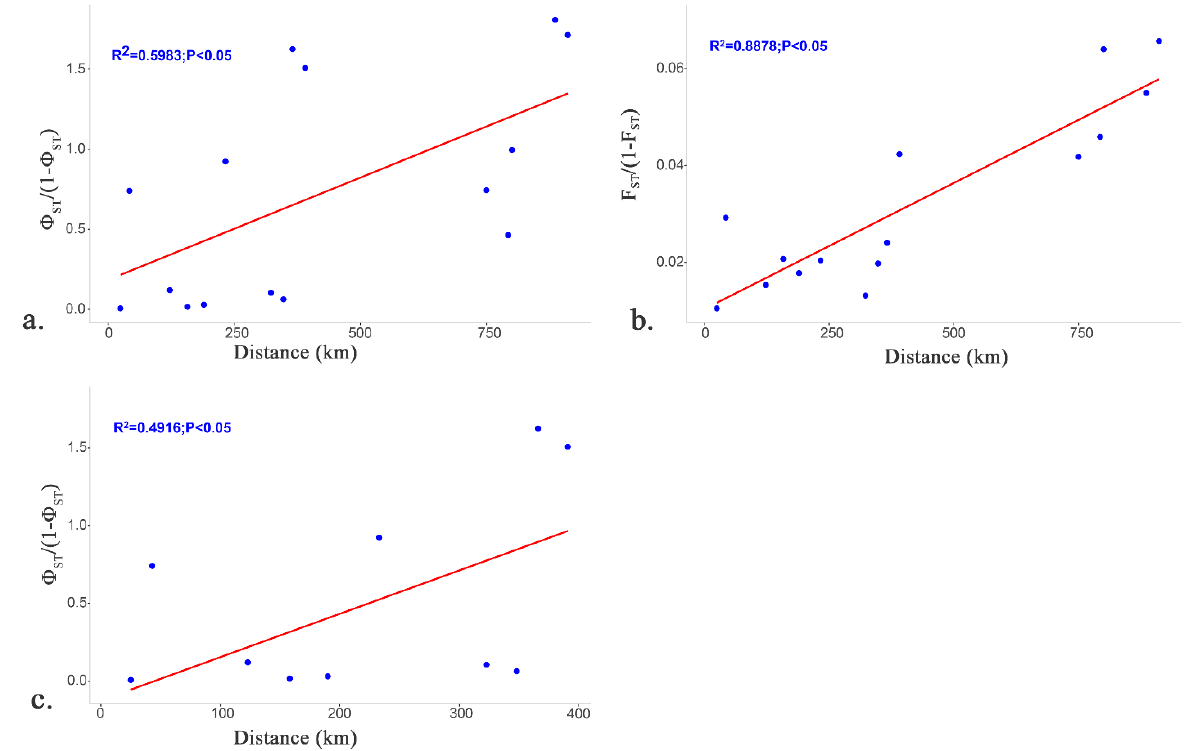
Figure 5. Correlation between geographic and genetic distances. ( a ) Mantel tests based on 1091 bp D-loop region sequences for all six locations; ( b ) Mantel tests based on the 5 microsatellite loci for all six locations; ( c ) Mantel tests based on D-loop region sequences for all six locations excluding individuals from the Hengxian.